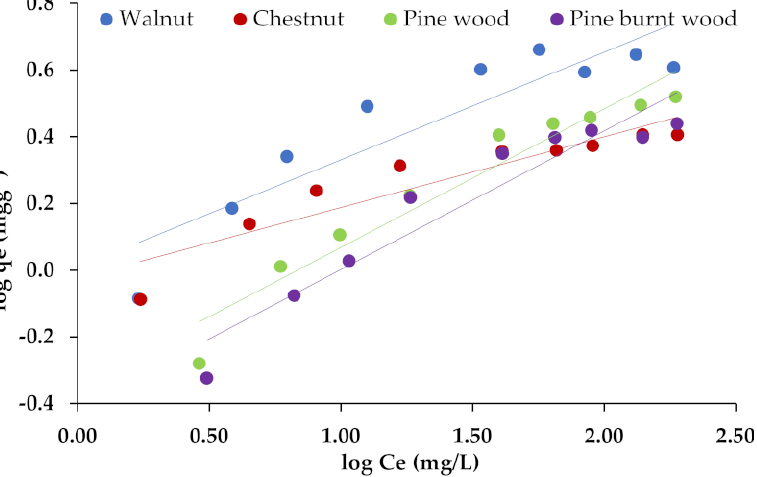
Figure 9. Freundlich isotherm model for nickel adsorption with nickel concentrations from 5 to 200 mg L − 1 and 100 mg of adsorbent. Table 2. Isotherm parameters of nickel adsorption onto the lignocellulosic materials. Langmuir